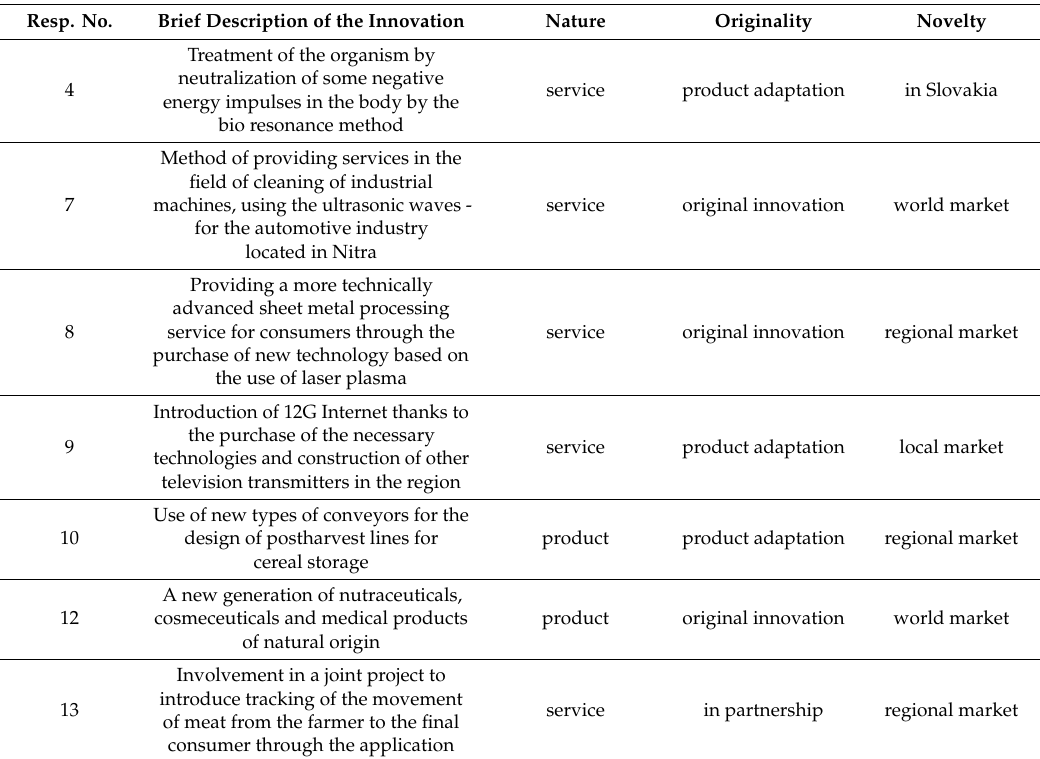
Table 5. An overview of product and service innovations in the